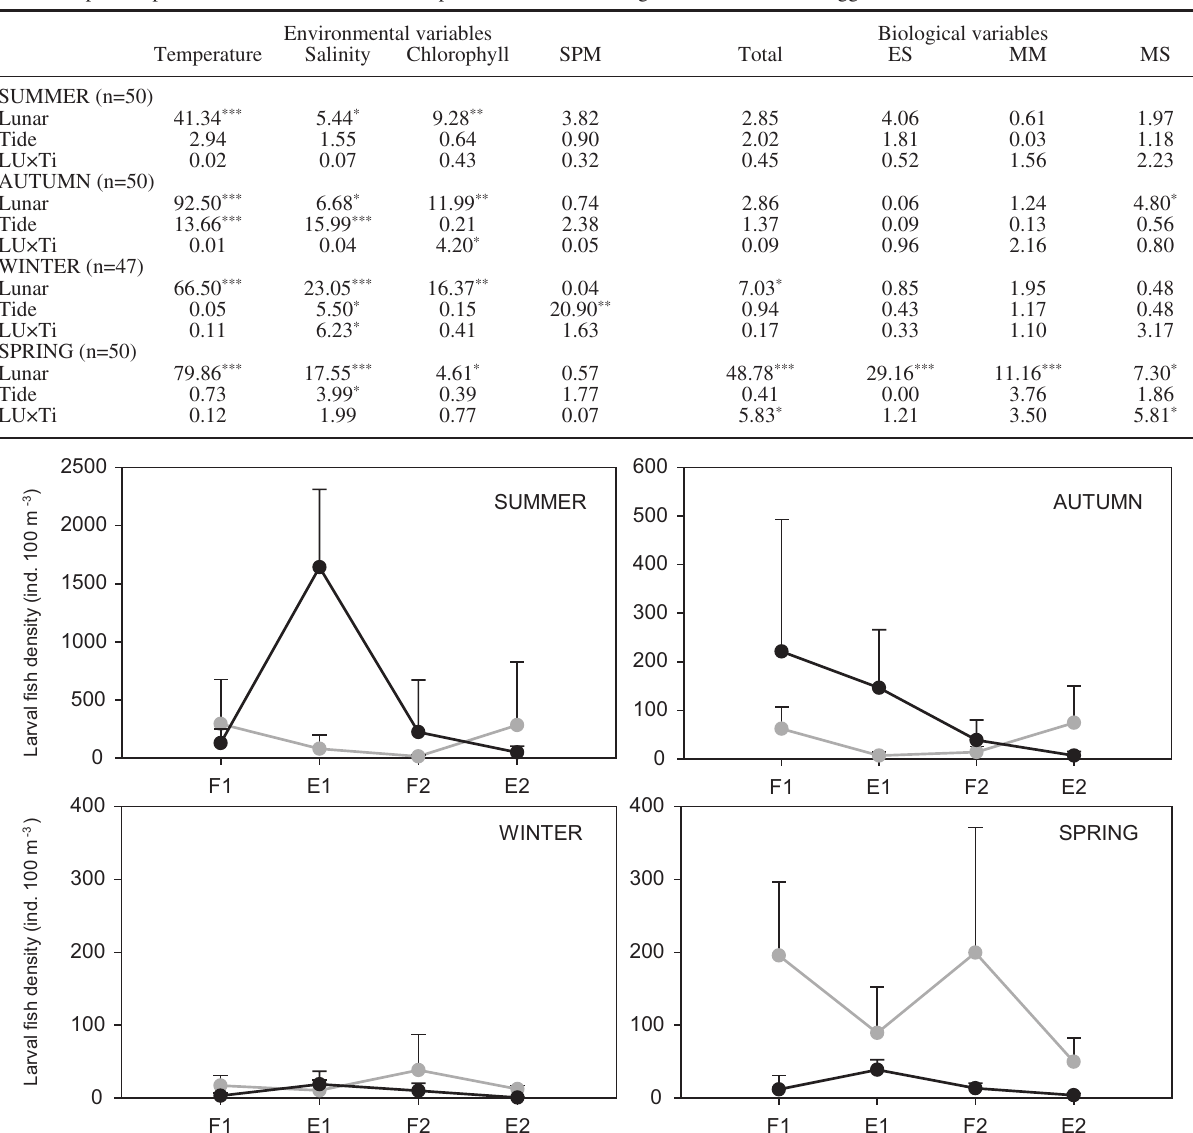
Table 1. – Summary results (Pseudo-F values) from 2-way univariate PERMANOVA analysis on environmental and biological variables. SPM, suspended particulate matter; ES, estuarine species; MM, marine migrants; MS, marine stragglers. *** P ≤ 0.001; ** P ≤ 0.01; * P ≤ 0.05.